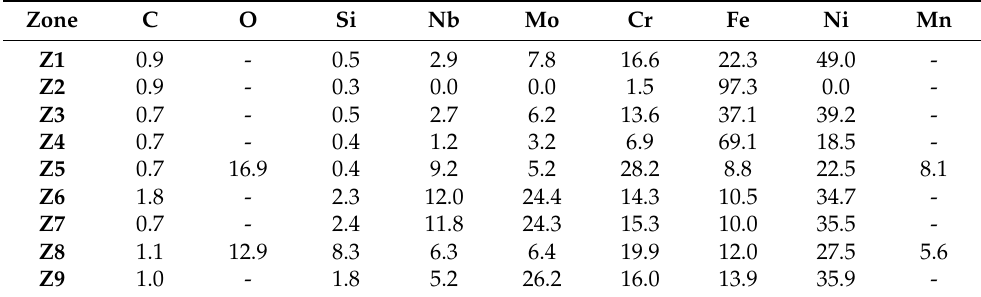
Table 2. EDS analysis (wt.%) performed on the FGM zones illustrated in Figure 6. Z1, Z2, Z5, Z6, and Z7 are from FGMs without PHT, and Z3, Z4, Z8, and Z9 from FGMs with